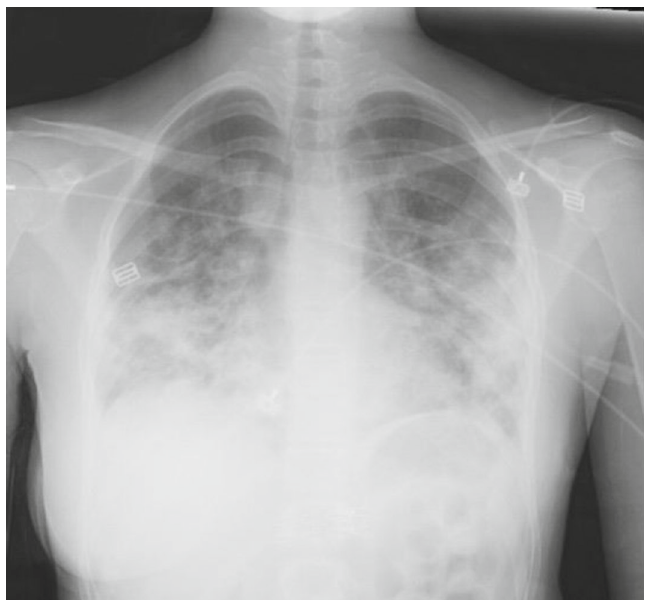
Figure 1: Admission chest radiograph demonstrates bilateral ill-de fi ned opacities with mid and lower lung